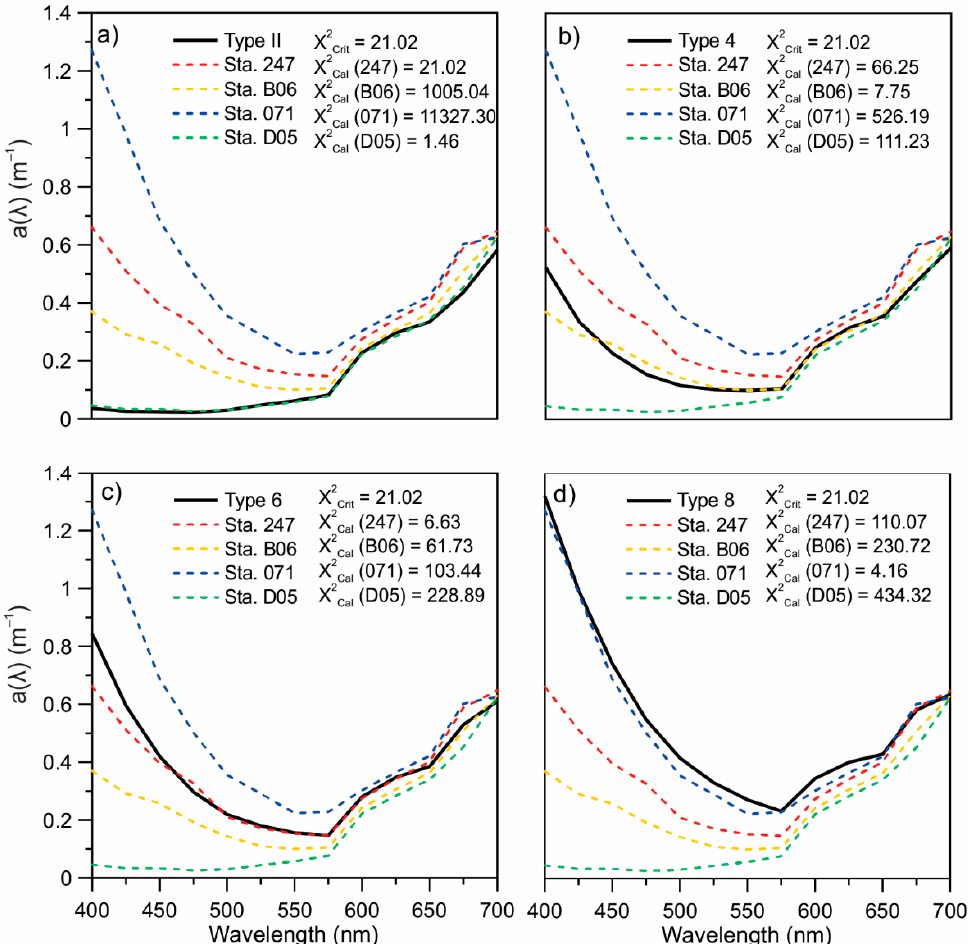
Figure 6. Least-squares fitting method for four selected stations. The black line indicates a ( λ ) values for the di ff erent water types; the dotted line, a ( λ ) in situ for stations. χ 2 marks the maximum allowable tolerance for the fit. ( a ) Example of the fit for type II, where station D05 gave the best fit; ( b ) example of the fit for type 4, where station B06 gave the best fit; (c) example of the fit for type 6, where station 247 gave the best fit; ( d ) example of the fit for type 8, where station 071 gave the best fit.